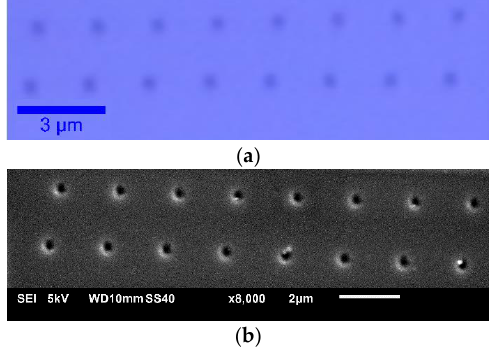
Figure 4. Pattern visualization with ( a ) confocal 100x and ( b ) scanning electron microscopy.